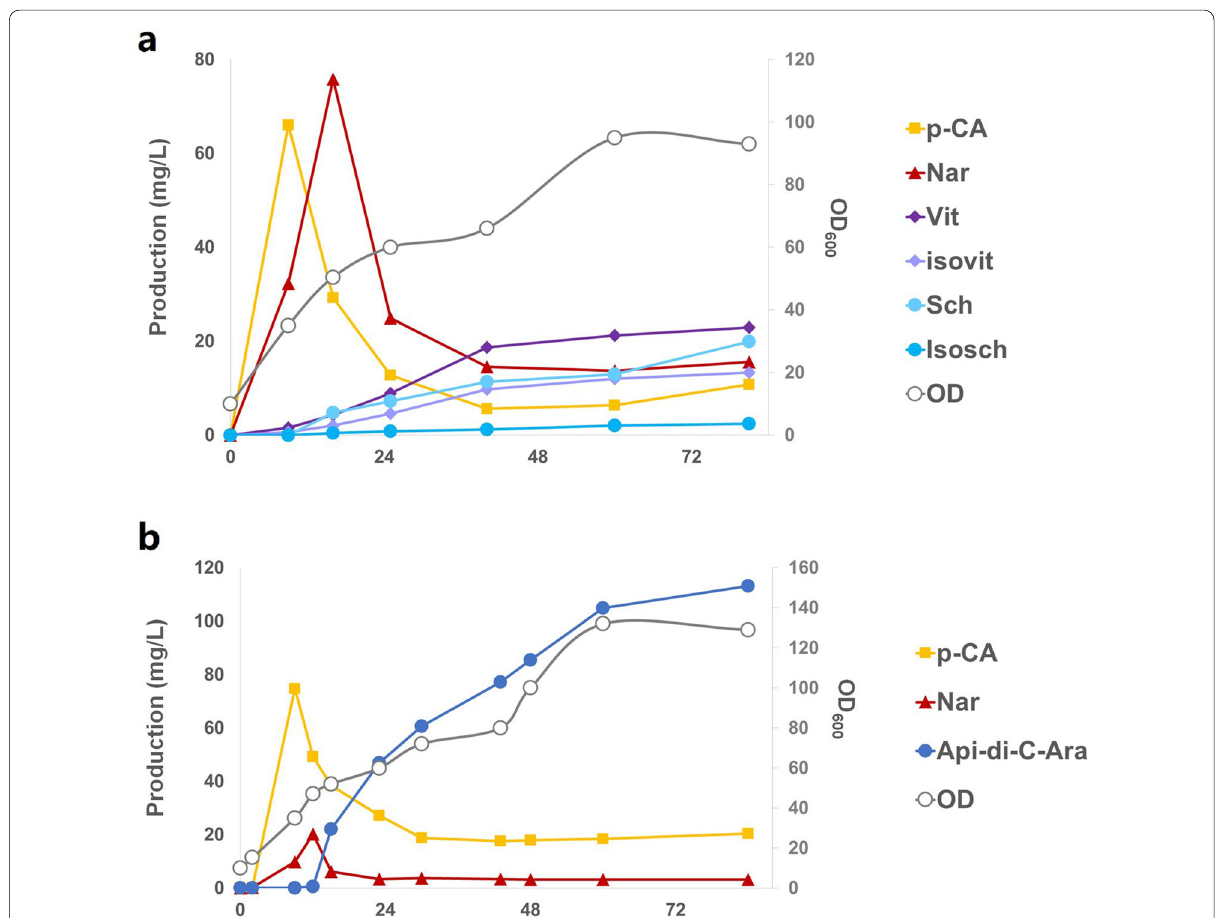
Fig. 5 Fed-batch fermentation of C -arabinosides. a Fed-batch fermentation of sCZ113 in 5-L bioreactor. b Fed-batch fermentation of sCZ118 in 5-L